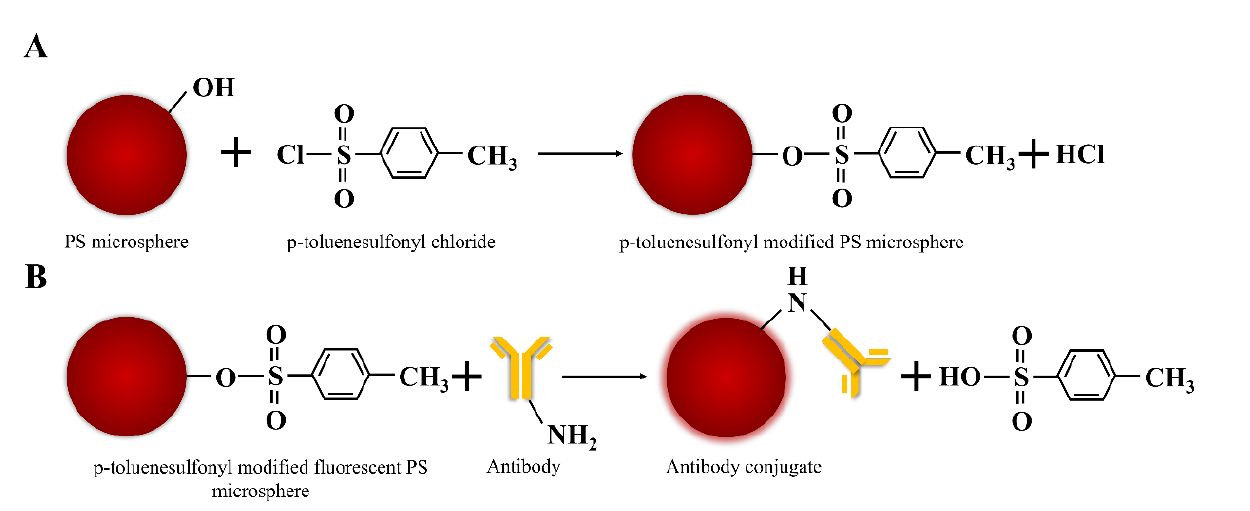
Figure 2. ( A ) Schematic diagram of p-toluenesulfonyl modified PS microspheres. ( B ) Conjugation of antibodies to p-toluenesulfonyl modified fluorescent PS microspheres.